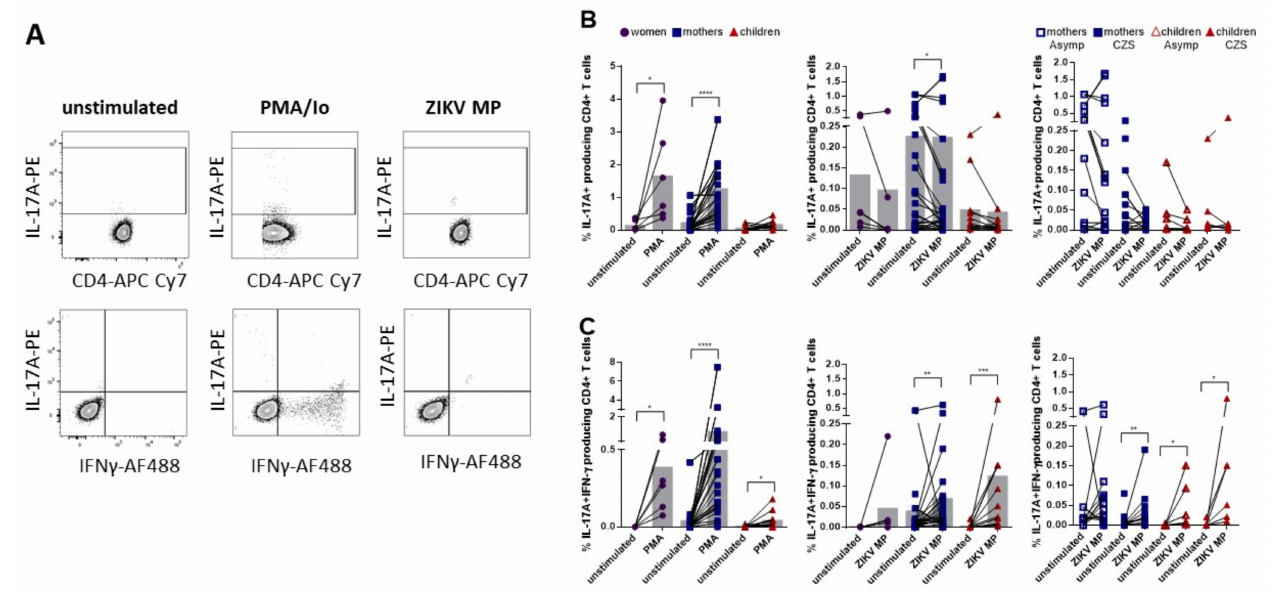
Figure 6. Frequencies of the responding IL-17- and IL-17+ IFN- γ +-producing CD4+ T cell subsets in individuals with histories of ZIKV. Cytokine-producing CD4+ T cells were measured in women (from non-pregnant women infected with ZIKV, violet circles, n = 6), mothers (from pregnant mothers infected with ZIKV, blue squares, n = 21) and children (from children born to mothers infected with ZIKV during pregnancy, red triangles, n = 12) with histories of ZIKV infection, after stimulation with ZIKV MP. ( A ) Representative gating of IL-17+ IFN- γ − and IL-17+ IFN- γ +-producing CD4+ T cell subsets from donor PBMCs is shown. Percentages of ( B ) IL-17+ IFN- γ − and ( C ) IL-17+ IFN- γ +- producing CD4+ T cell subsets in each group. Cytokine-producing CD4+ T cells were also evaluated between the mothers who had asymptomatic babies ( n = 11) and those who had babies with CZS ( n = 10) and between the asymptomatic children ( n = 6) and those born with CZS ( n = 6). Differences between cells stimulated with ZIKV MP and unstimulated cells were analyzed using the Wilcoxon matched-pairs signed rank test. Each data point represents a single individual determination without (unstimulated) and after stimulation with ZIKV MP. Grey bars represent the mean for each group. Asterisks indicate significant differences (* p < 0.05, ** p < 0.01, *** p < 0.001, **** p <